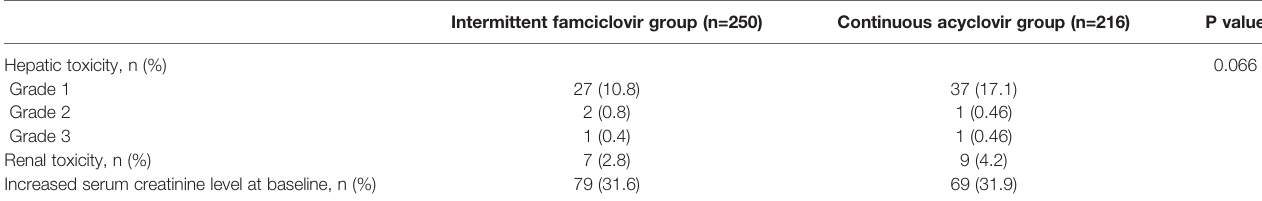
TABLE 3 | Hepatic and renal toxicities.